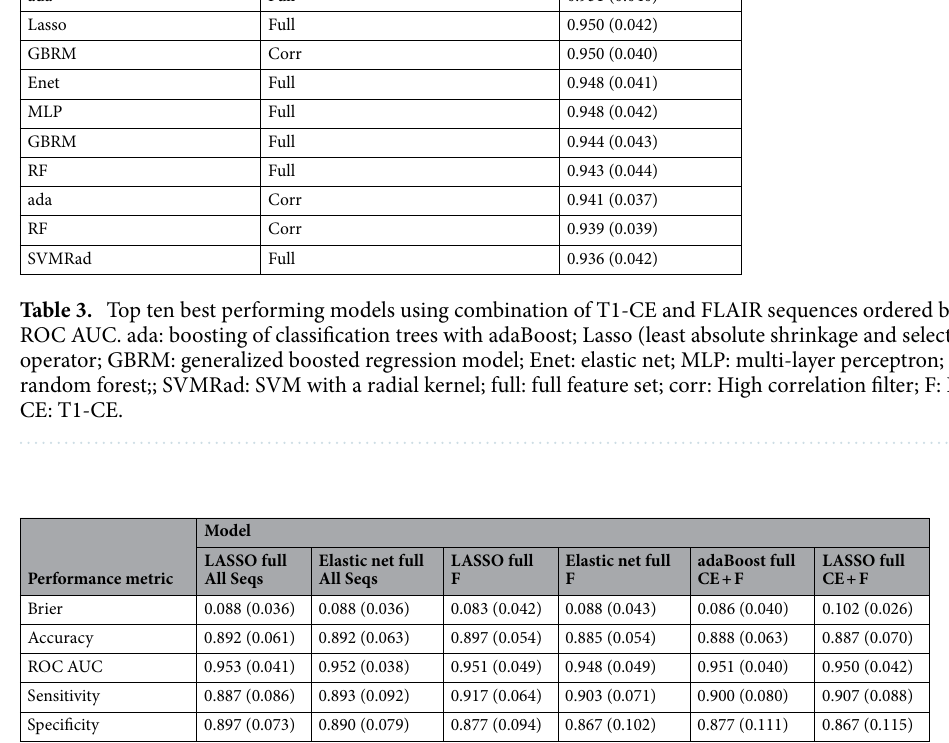
Table 4. Mean (SD) of performance metrics for two best performing models using all sequences, individual sequences, and combined T1-CE and FLAIR sequences. LASSO (least absolute shrinkage and selection operator; Enet: elastic net; ada: boosting of classification trees with adaBoost; F: FLAIR; CE: T1-CE.